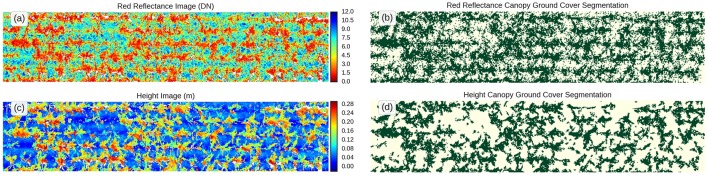
Canopy ground cover determination. Top views of the same experimental plot. False color scale for (a) red reflectance and (c) height. Binary images showing estimation of canopy ground cover after canopy segmentation using threshold values for (b) reflectance (<5) and (d) height (10 cm).